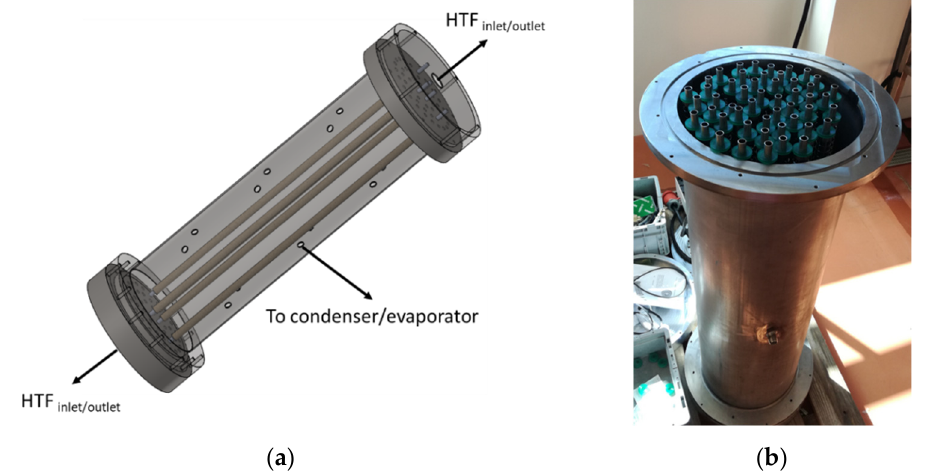
Figure 1. ( a ) Adsorber schematic; ( b ) adsorber with fifty tubes covered with silica gel.